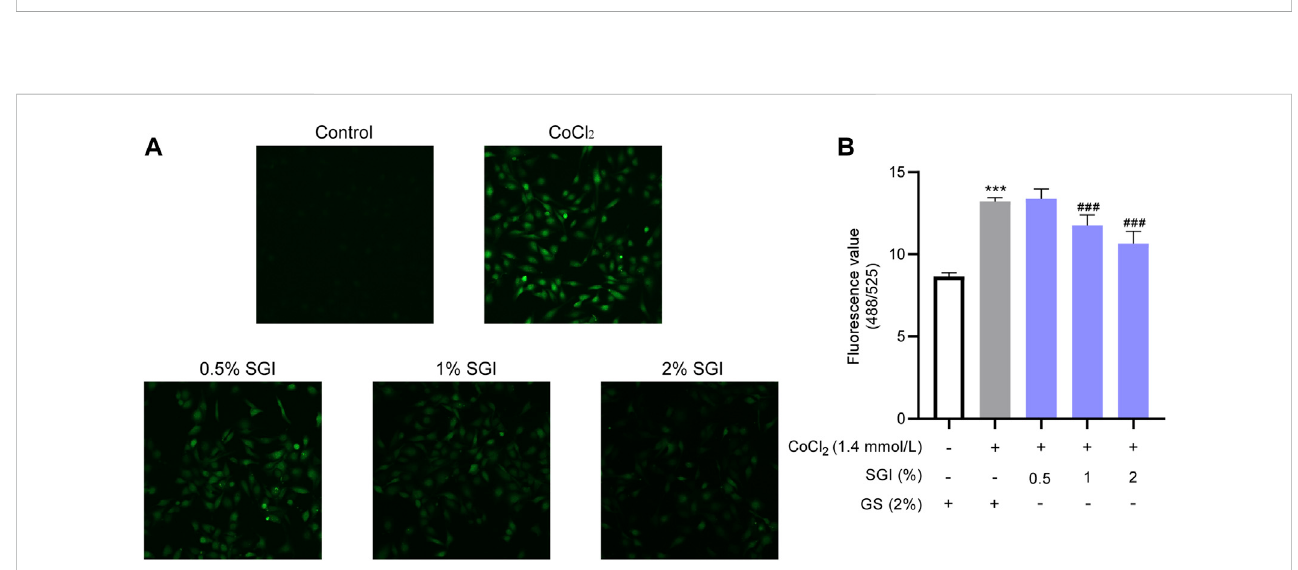
FIGURE 4 SGIinhibitsCoCl 2 -inducedinjuryinHUVECs. (A) HUVECsweretreatedwithdifferentconcentrationsofCoCl 2 fortheindicatedtimesandcellviabilitywas measured by MTS assay. (B) HUVECs were treated with SGI and GS from 4% to 24% for 24 h and cell viability (C) was measured by MTS assay. (D) Cell morphology was examined by a light microscope. *** p < .001 vs. the control group; ## p < .01, ### p < .001 vs. the CoCl 2 group; $ p < .05, $$$ p < .001 vs. the GS group.